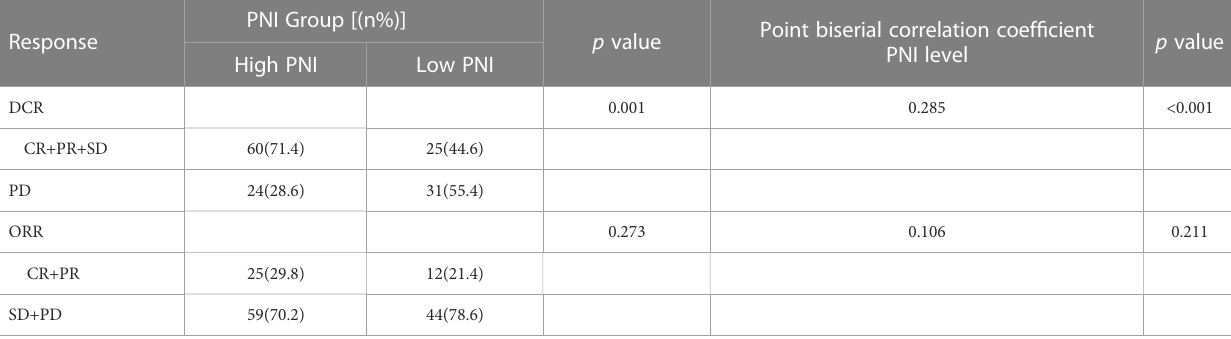
TABLE 3 Relationship between clinical response and PNI groups in SCLC patients treated with PD-L1/PD-1 inhibitors combined with chemotherapy.